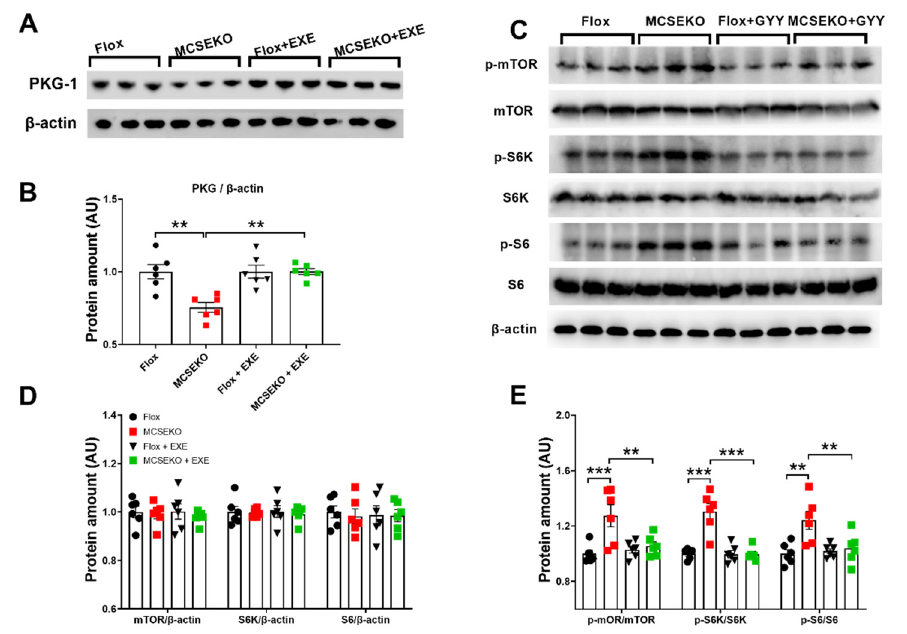
Figure 9. Aerobic treadmill exercise increases PKG-1 level and suppresses mTOR/S6K/S6 signaling in the skeletal muscle of the MCSEKO mice. MCSEKO mice and Flox mice were housed under standard conditions. Aerobic treadmill exercise was performed on the mice at 14-weeks-old for six weeks. ( A , B ) Western blot analysis of PKG-1 protein level in GAS muscle. ( C – E ) Western blot analysis of p-mTOR, mTOR, p-S6K, S6K, p-S6, S6 protein levels in GAS. ( A , C ) The representative images of western blotting. ( B , D , E ) Cumulative data of western blotting images. Data were expressed as means ± SEM ( n = 6 in each group). ** p < 0.01, *** p < 0.001. EXE: exercise.